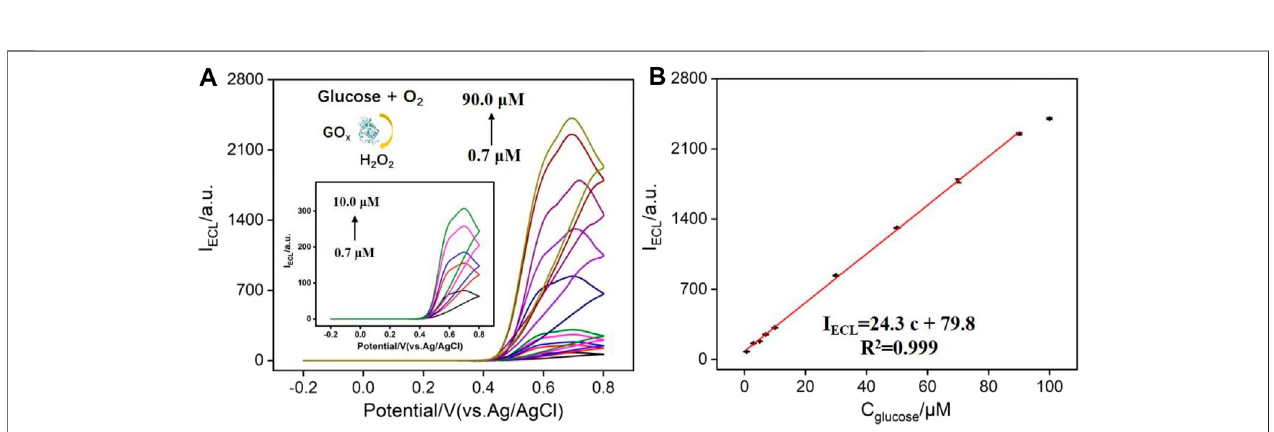
FIGURE 6 | (A) ECL intensity of N-GQDs in response to different concentrations of glucose (preincubated with glucose oxidase) in PBS (0.1 M, pH (cid:2) 10.0). (B) Calibration curve for the detection of glucose.